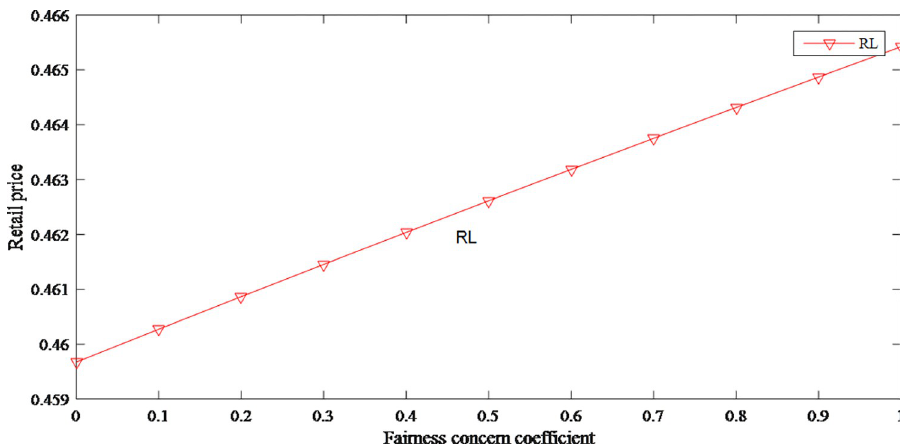
Fig 8. The impact of fairness concern on retail price.